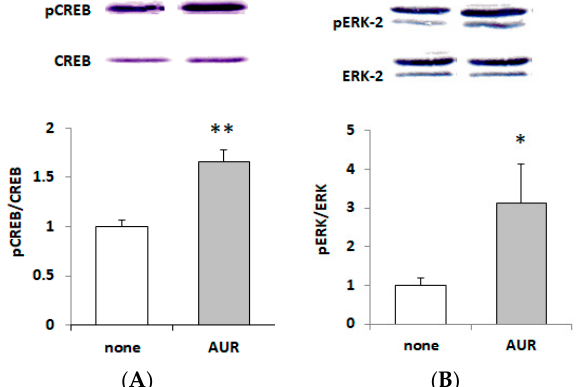
Figure 5. Effects of treatment with AUR on phosphorylation of cAMP response element-binding protein (CREB) ( A ) and extracellular signal-regulated kinase 2 (ERK2) ( B ) in C6 cells. Cells were incubated with 20 μ M AUR for 40 h. The density ratio of phosphorylated components to total components of untreated cultures (none) was expressed as 1.0. The results are given as the mean ± SEM ( n = 3). Significance difference in values between the none-treated and AUR-treated cells: * p < 0.05; ** p < 0.01.